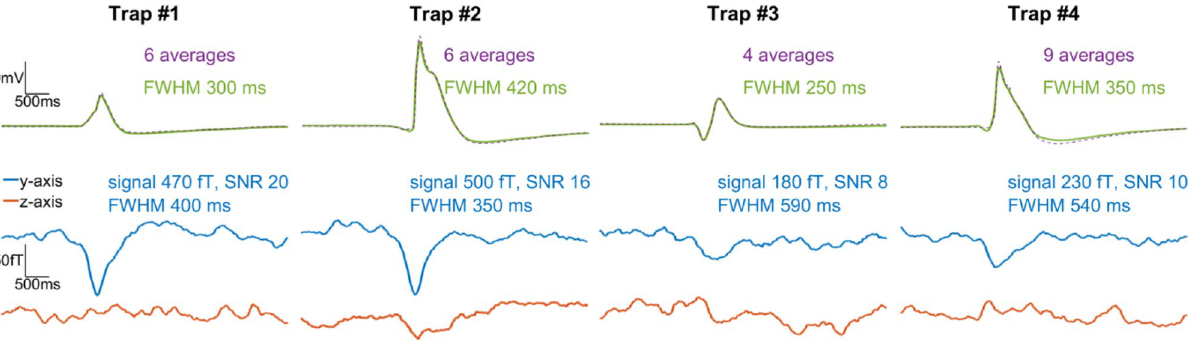
Figure 5. Comparison of average electric and gradiometric signals from four different experiments. In each case we triggered on heat-induced APs in the electric trace and performed the same data analysis as for Fig. 4. The electric response recorded by the surface electrodes (top row; average signal plotted as solid green, single AP plotted as dashed purple) varies in amplitude because a different plant sample was used in each experiment. To produce the gradiometric plots (bottom graphs) we subtracted the magnetic data of background sensor D from that of primary sensor A. The number of averages in each experiment is indicated, along with the amplitude and signal-to-noise ratio (SNR) of the y -axis gradiometric signal. The rightmost panel (Trap #4) shows the same data set as in Fig.